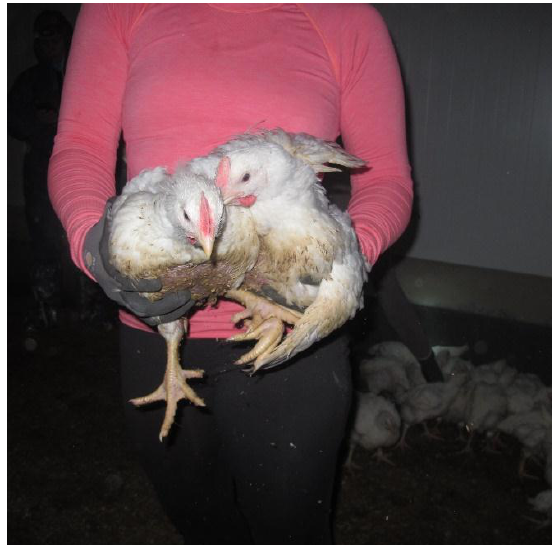
Figure 2. Catching under the abdomen and carrying the broilers upright.